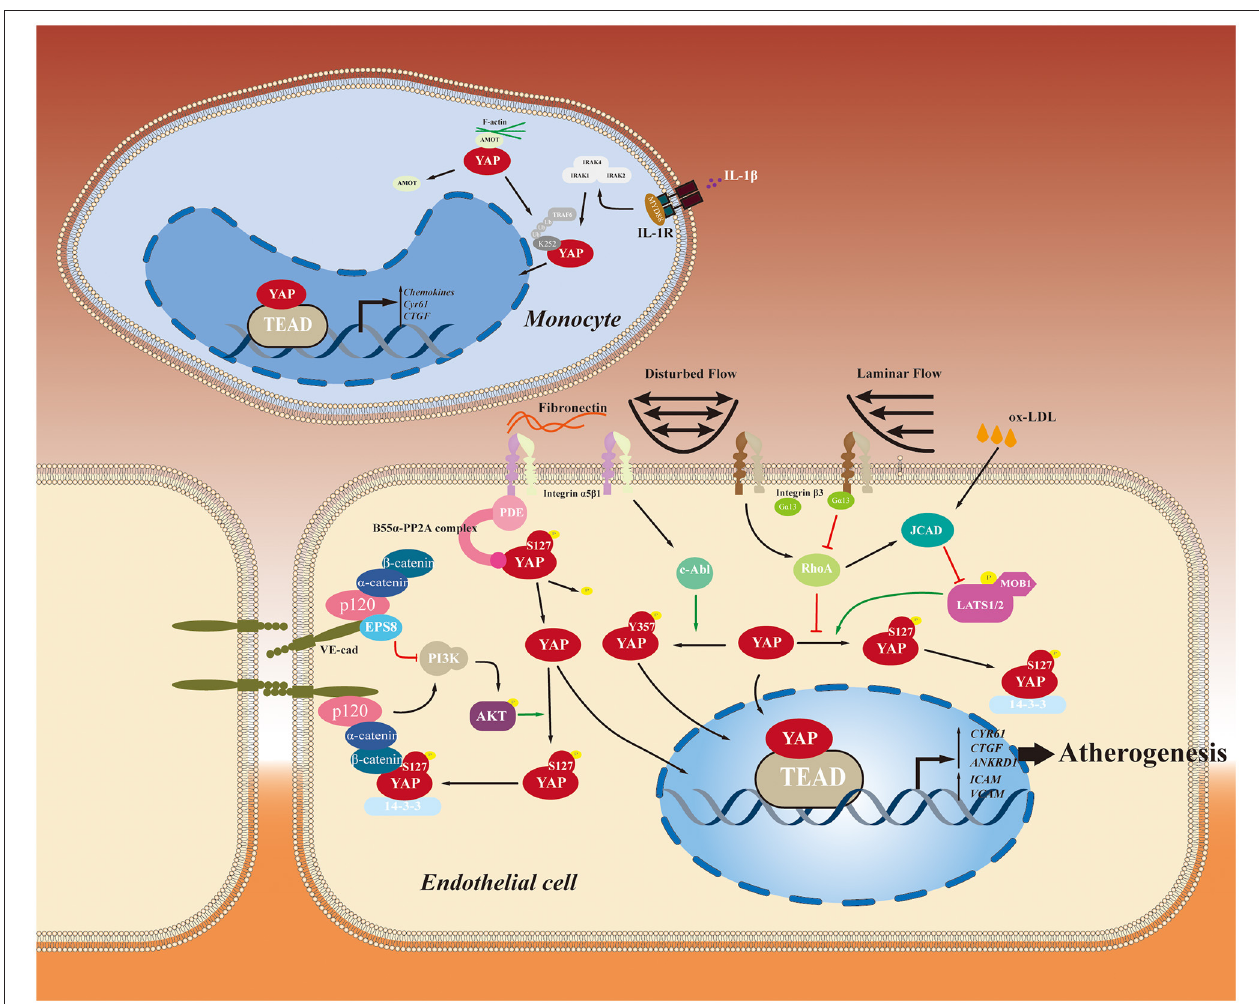
FIGURE 3 | YAP roles played in endothelial cells and monocytes in the context of atherosclerosis initiation. YAP-related pathways involved in the initiation and development of atherosclerosis are summarized.